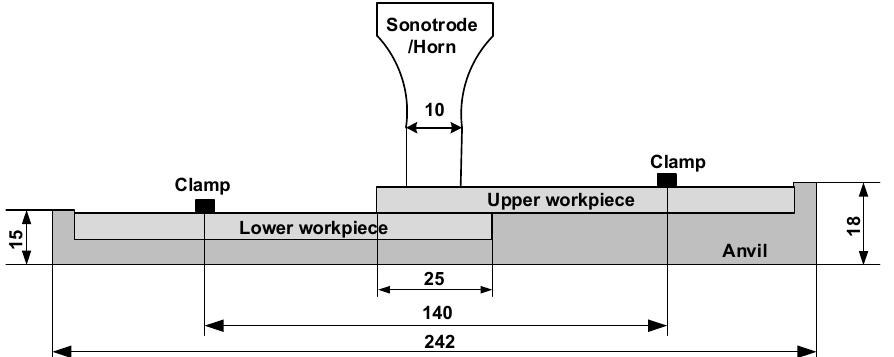
Figure 2. Schematic of ultrasonic welding of injection-molded 2.3-mm-thick lapped C f /PA6 compo- site without energy director (Dimensions in mm).